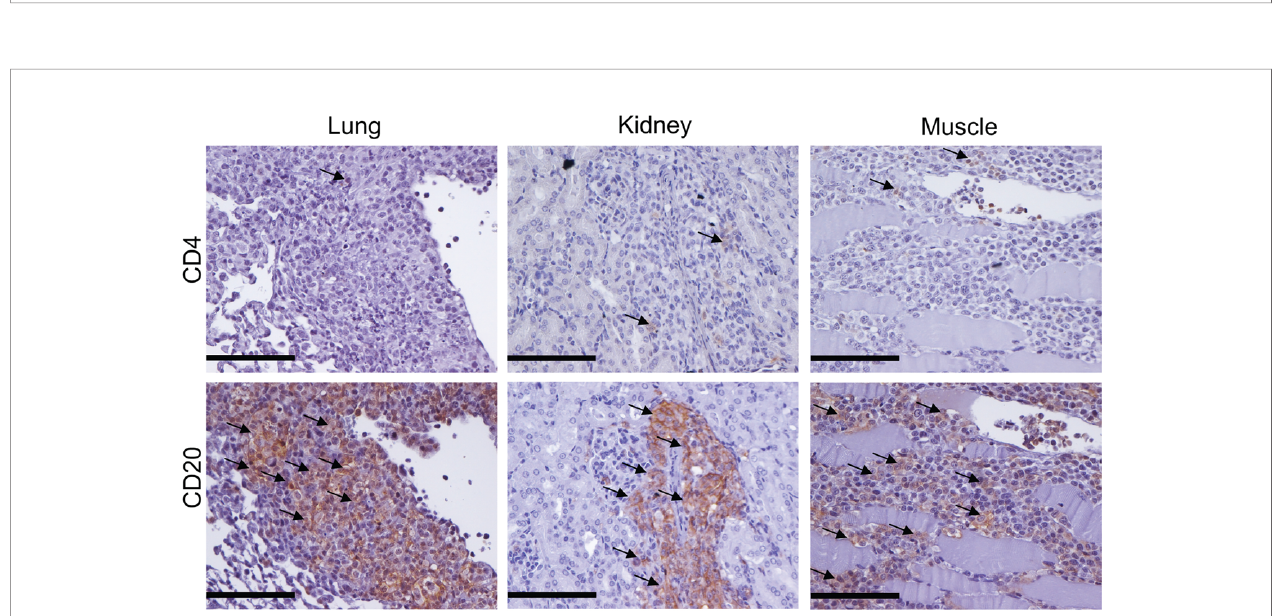
FIGURE 4 | Cellular in fi ltrates in mice transferred with SSc-PBMC are dominated by human B cells. Human lymphocytes in lung, kidney and muscle of recipient mice were examined by immunohistochemistry staining with anti-hCD4 and anti-hCD20 antibodies. Representative micrographs of the staining are shown (bar =